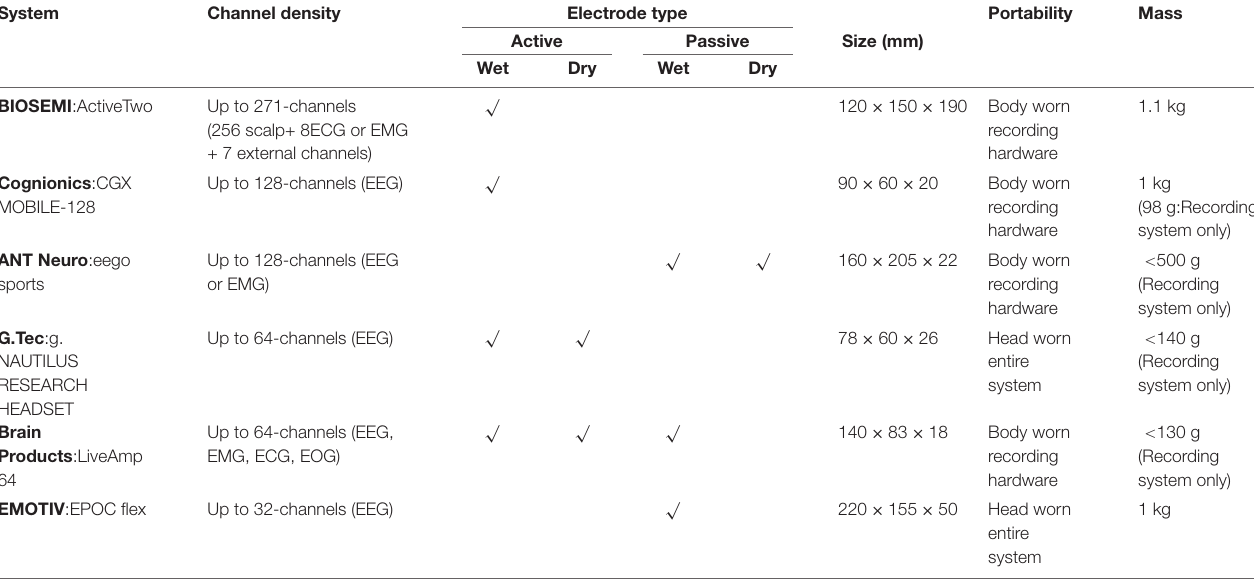
TABLE 1 | Mobile high-density EEG systems for studying neural control of human